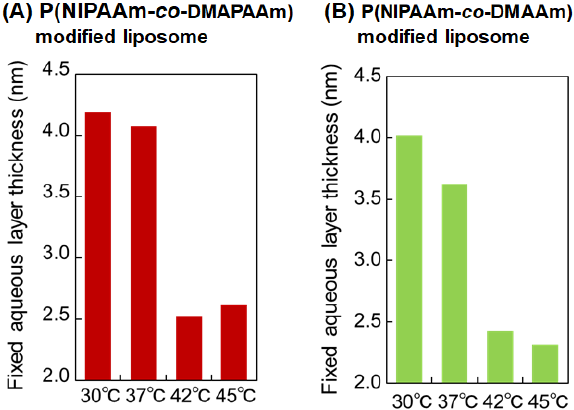
Figure 5. Temperature dependence of the fixed aqueous layer thickness (FALT) of temperature- responsive liposomes. The FALT was calculated using Gouy-Chapman theory.